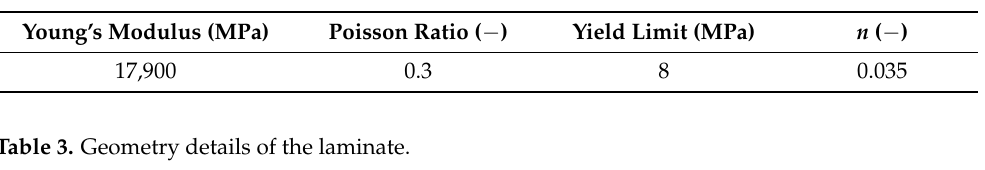
Table 2. Mechanical properties of the laminate.